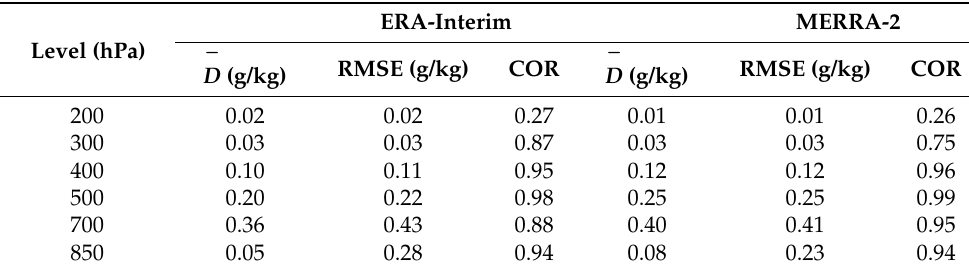
Table 1. General characteristics of average statistics between ERA-interim, MERRA-2 and ra- diosonde